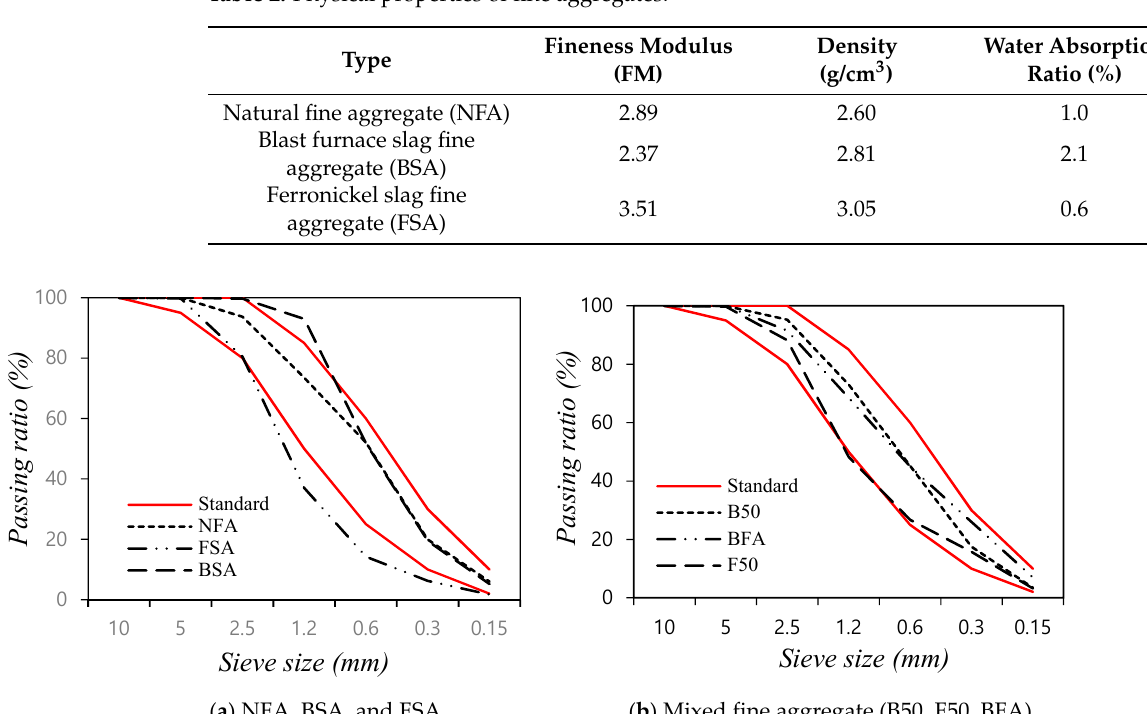
Table 1. Chemical composition of cementitious materials. Table 2. Physical properties of fine aggregates. Table 2. Physical properties of fine aggregates.